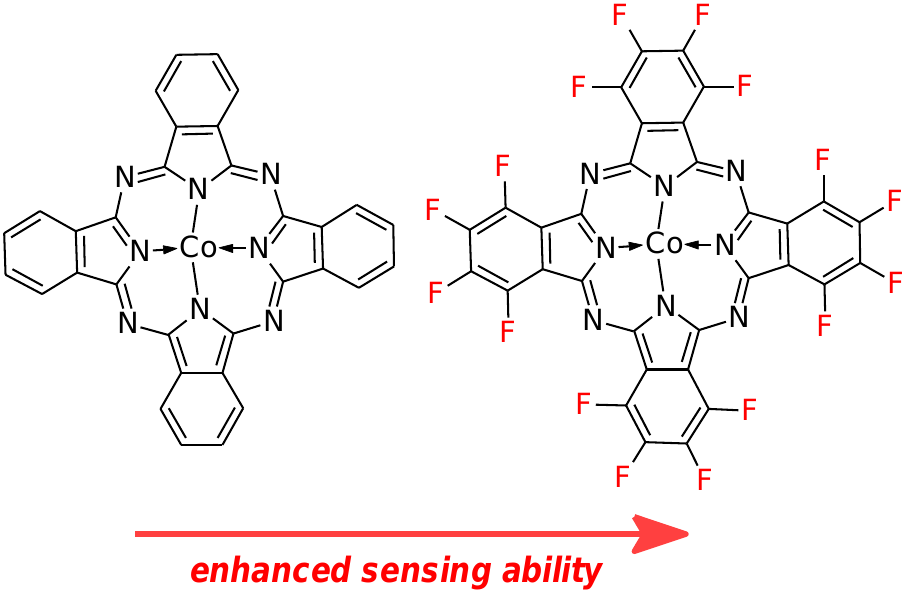
Figure 5. The chemical structures of unsubstituted and hexadecafluorinated cobalt(II) phthalocya-